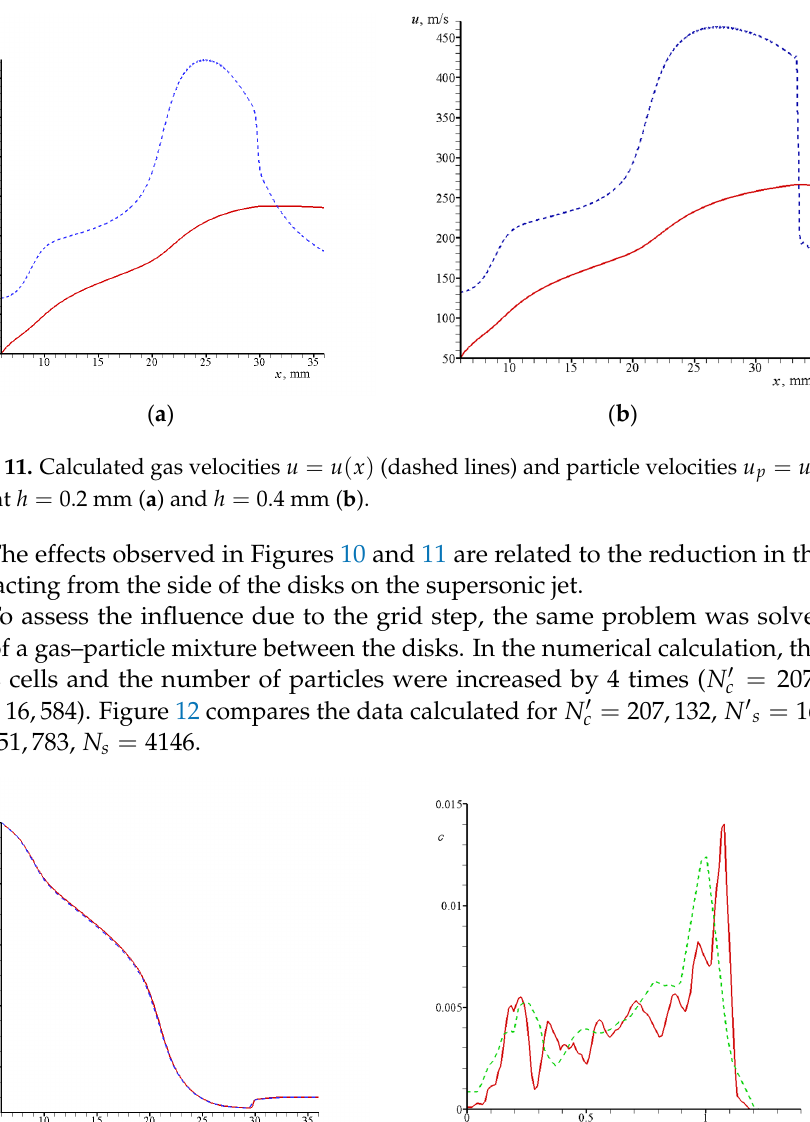
N   and c N   and N  and 4146 N  c c s N  and 4146 N  c s